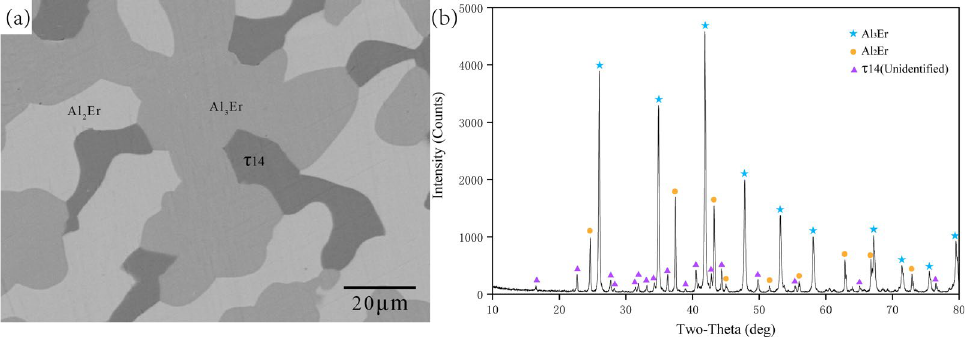
Figure 8. Sample B2’s ( a ) BSE image and ( b ) XRD pattern.